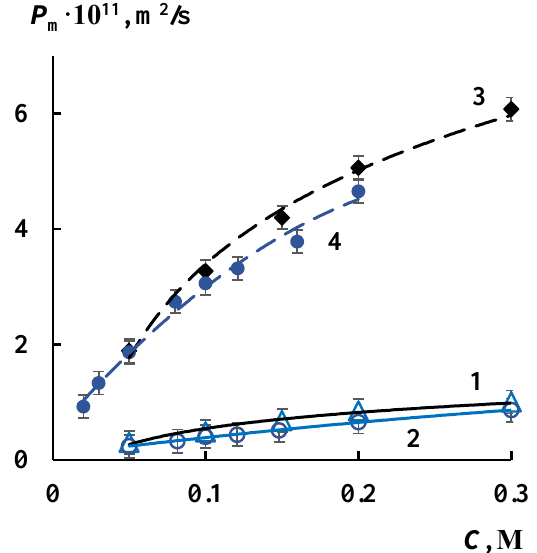
Figure 7. Concentration dependences of the integral diffusion permeability coefficient for MF-4SK (1, 2) and MF-4SK/HZP (3, 4) membranes in NaCl (1, 3) and HCl (2, 4) solutions.